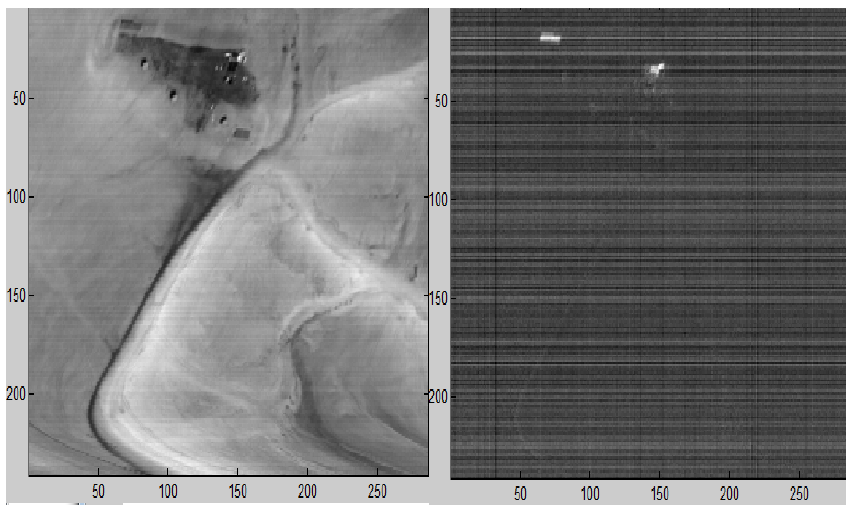
Figure 19. Left: The source image. Right: The result from the application of the projection separators. The white points contain a targets with t ≥ 0 . 7